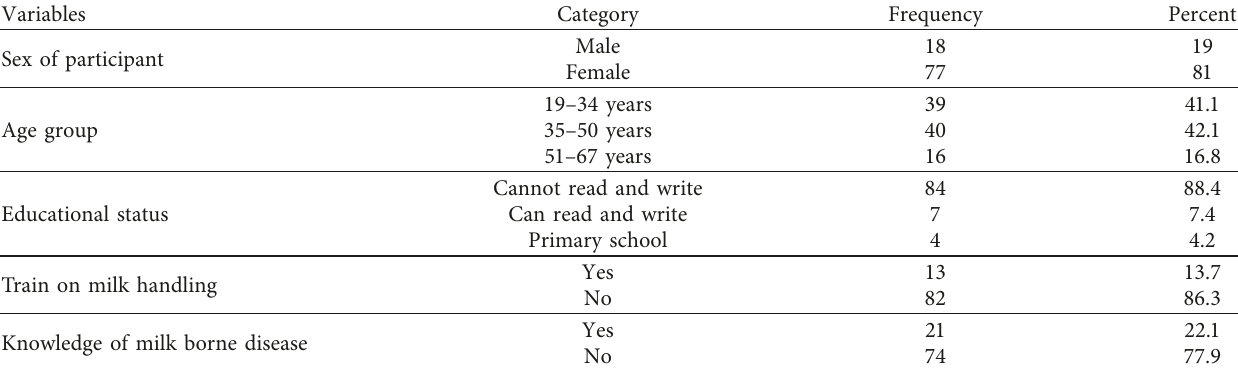
Table 1: Sociodemographic characteristics and knowledge of milk owner Borena zone in Gomole district, Southern Ethiopia, 2019. Variables